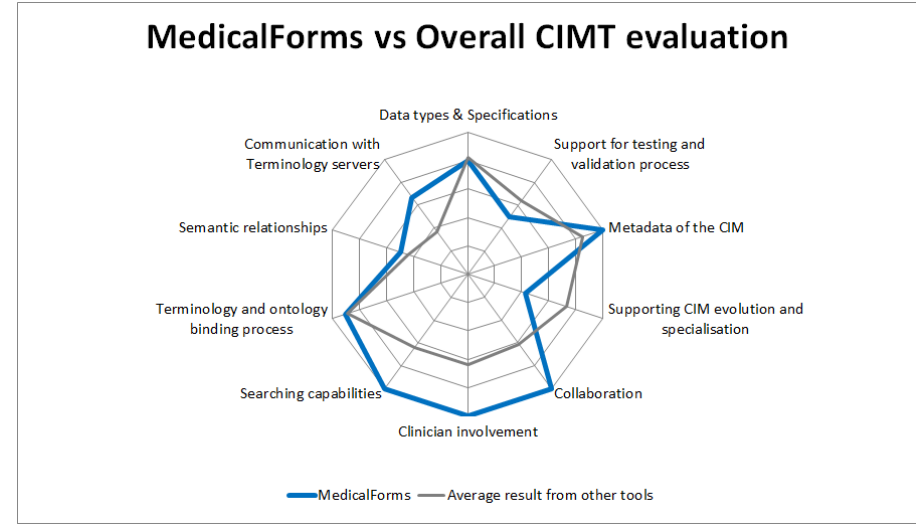
Figure 2. Comparison between the evaluation of the MedicalForms system against the requirements for CIMTs defined in a previous Delphi study, and average results from tools included in that study.